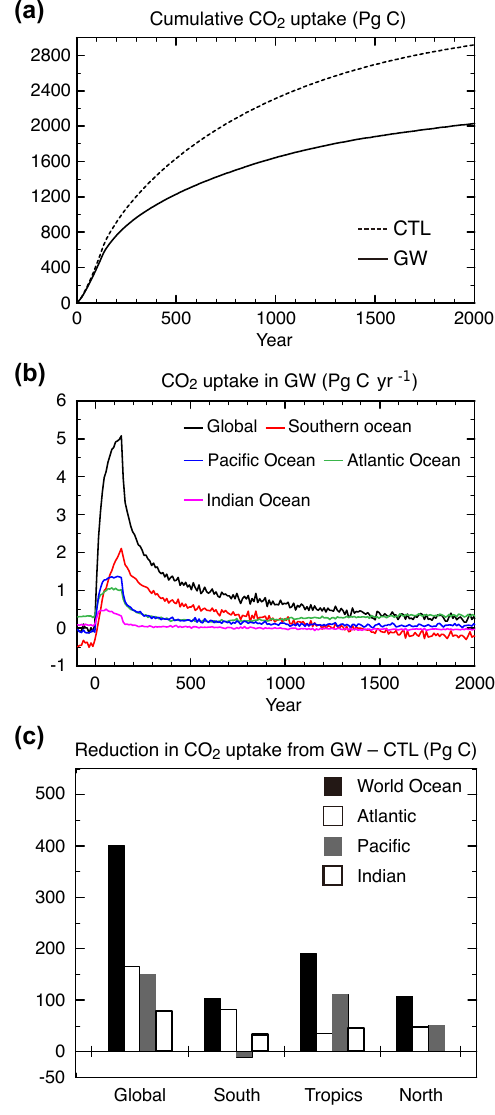
Figure 3. (a) Time series of the cumulative oceanic CO 2 uptake for CTL (dashed line) and GW (solid line). (b) Time series of the annual mean values of the oceanic CO 2 uptake for the global ocean (black) and different ocean basins (colors) in GW. (c) Reduction in the oceanic CO 2 uptake due to global warming for the global ocean and three ocean basins at 500 years (GW–CTL). The contributions of the global ocean and individual ocean basins are separated into three regions (South: south of 32.5 ◦ S; Tropics: 32.5 ◦ S to 32.5 ◦ N; North: north of 32.5 ◦ N). The positive and negative values represent uptake reductions and uptake increases,